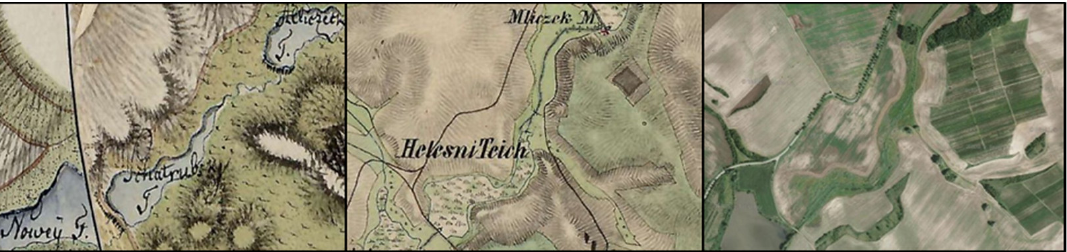
Figure 1. Map section from the first and second military mapping and an orthophoto image (from left to right) of a waterlogged area on the site of the defunct Helesné pond system in Cejkovice cadaster GPS (WGS84): 48.8719086N, 16.9257403E.